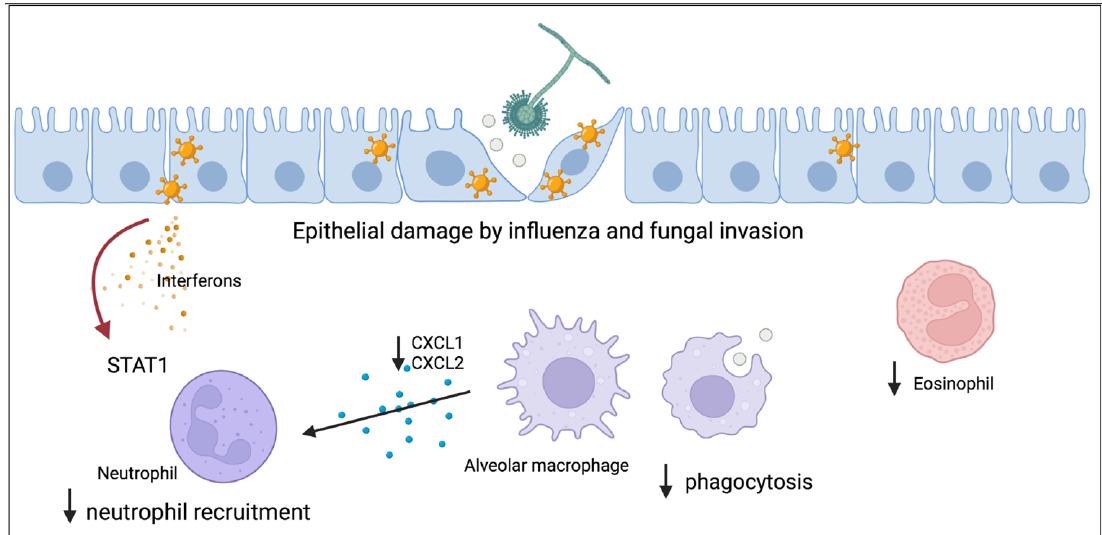
Figure 1. Proposed model for how influenza alters antifungal immunity and increases susceptibility to aspergillus infection. The first line of host defense is healthy respiratory epithelium which can be damaged by influenza and allow for fungal invasion. Resident alveolar macrophages phagocytose aspergillus and both total numbers and function of macrophages is inhibited by influenza. Macrophages secrete cytokines to recruit neutrophils to the lung and influenza inhibits neutrophil recruitment through STAT1 signaling. Eosinophils have antifungal properties and influenza decreases eosinophil levels during invasive pulmonary aspergillosis.